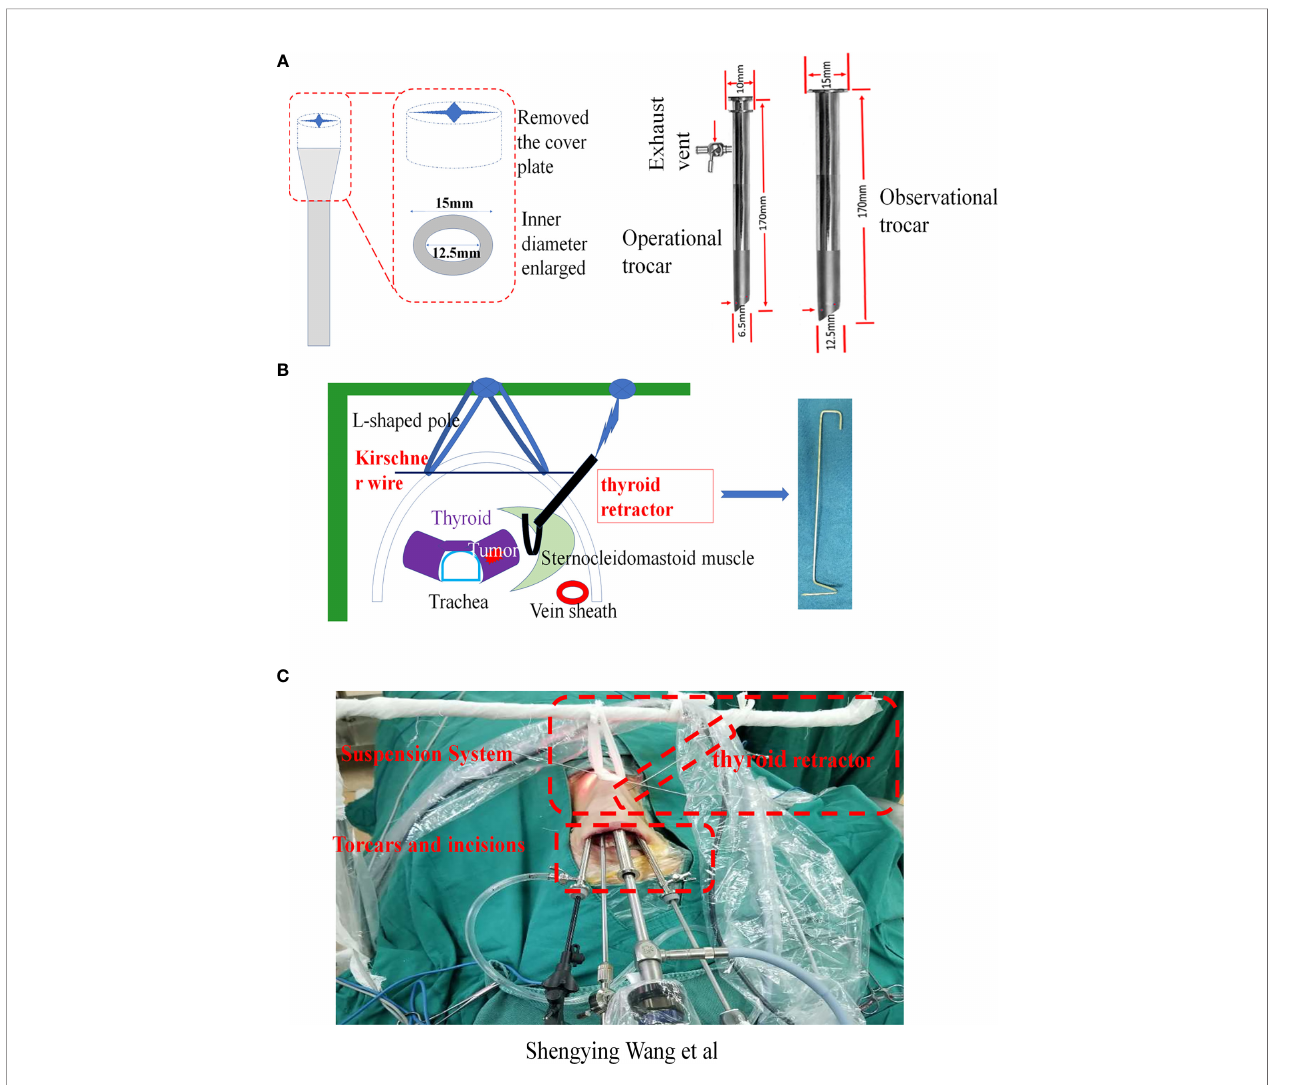
FIGURE 1 | Application of the new trocars and suspension system. (A) The details of the new trocars. (B) The details of suspension system. (C) Gasless TOETVA using the new trocars and suspension system (view from